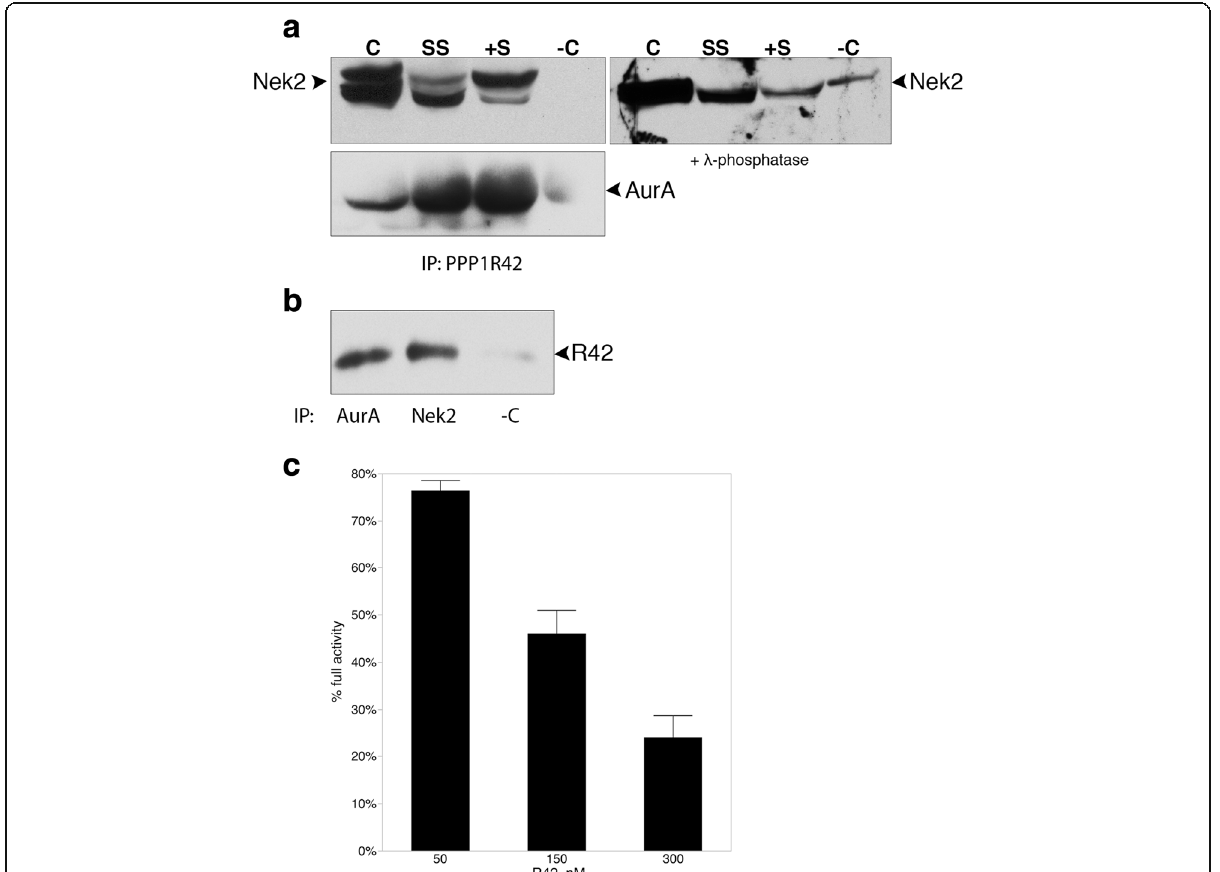
Fig. 8 PPP1R42 interacts with Nek2 and inhibits Nek2 activity in vitro. ( a ) PPP1R42 was overexpressed with either Nek2 or AurA in ARPE-19 cells, grown for 24 h (C, cycling) then the cells were induced to assemble cilia (SS, serum starved) followed by disassembly (+S, serum added back). Protein complexes were immunoprecipitated with anti-PPP1R42 antibody, or no antibody as negative control ( − C), and the blots probed for Nek2 or AurA. Immunoprecipitates were treated with λ -phosphatase and probed with Nek2 antibody ( a , right panel). ( b ) Protein complexes were immunoprecipitated from untransfected ARPE-19 cells with anti-AurA and anti-Nek2 antibodies and probed for PPP1R42. ( c ) Nek2 kinase activity was assayed in the presence of 50, 150 and 300 nM recombinant R42 protein and activity calculated as a percentage of untreated Nek2